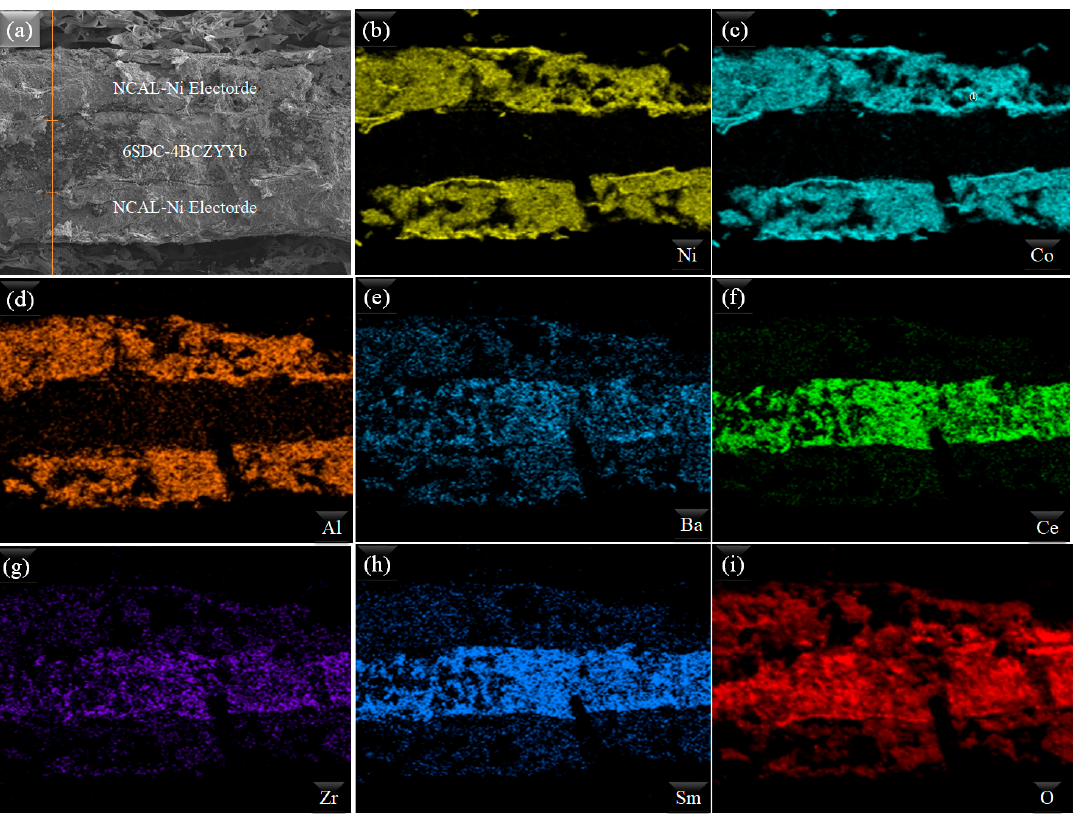
Figure 5. ( a ) Cross-sectional SEM images of tri-layer 6SDC-4BCZYYb-supported symmetrical fuel cell and NCAL electrodes examined after the electrochemical test. ( b – i ) EDs mapping of BCZYYb- SDC electrolyte and Ni, Co Al contents in NCAL electrode.